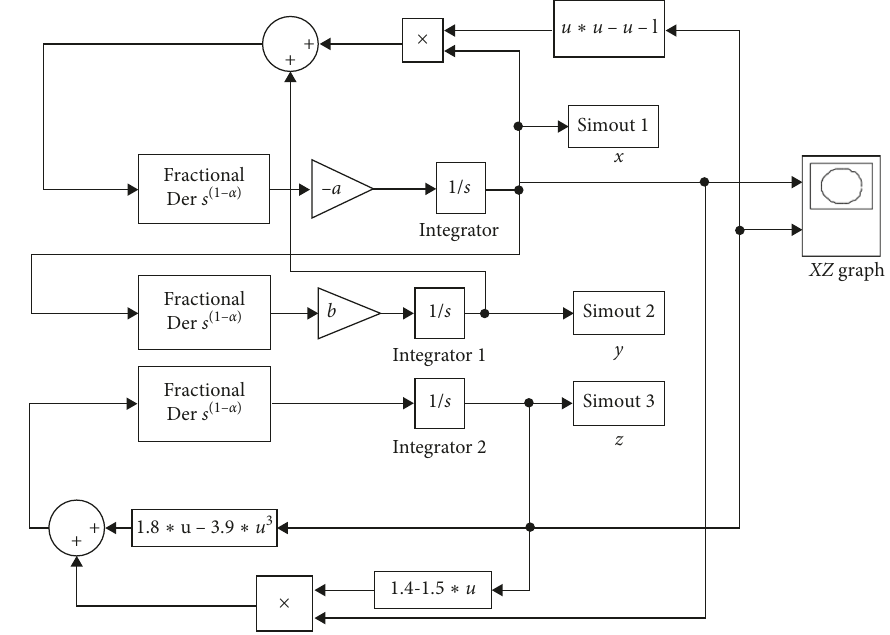
Figure 8: The block diagram of system (5) in Simulink of MATLAB.